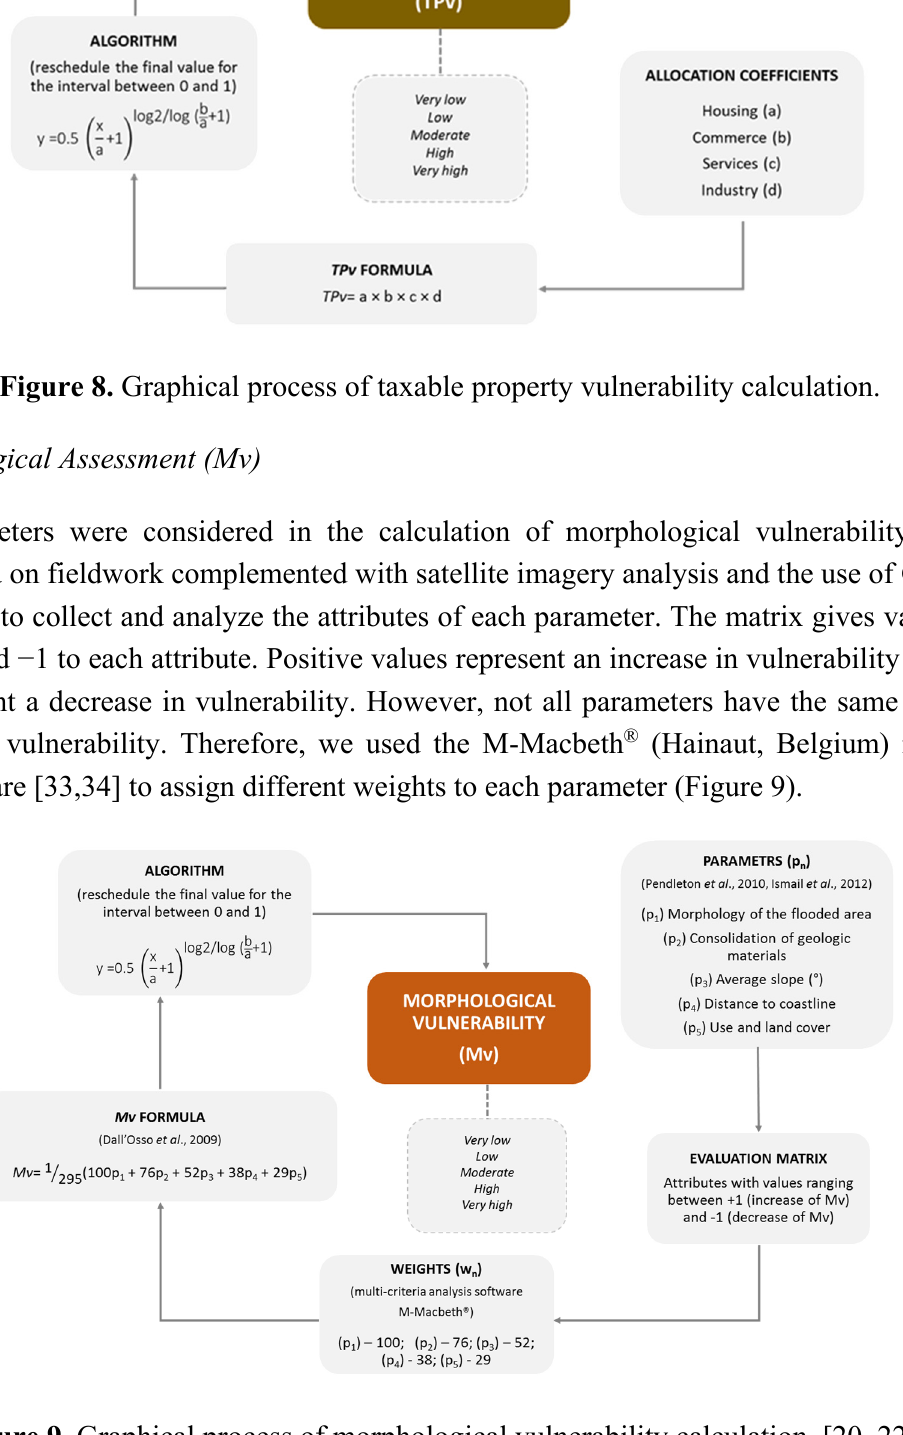
Figure 9. Graphical process of morphological vulnerability calculation.